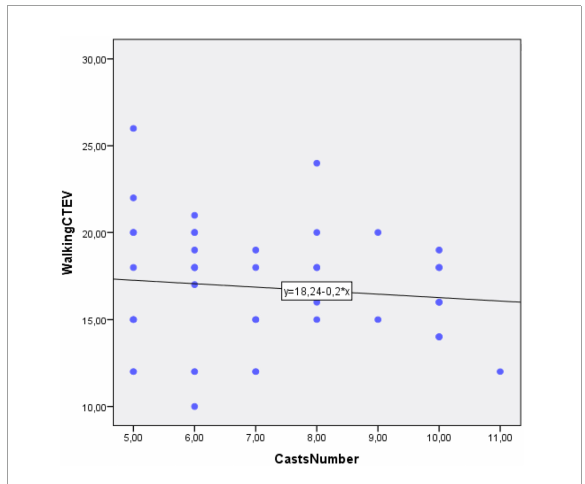
FIGURE6 Correlation between independent gait and Number of Casts.